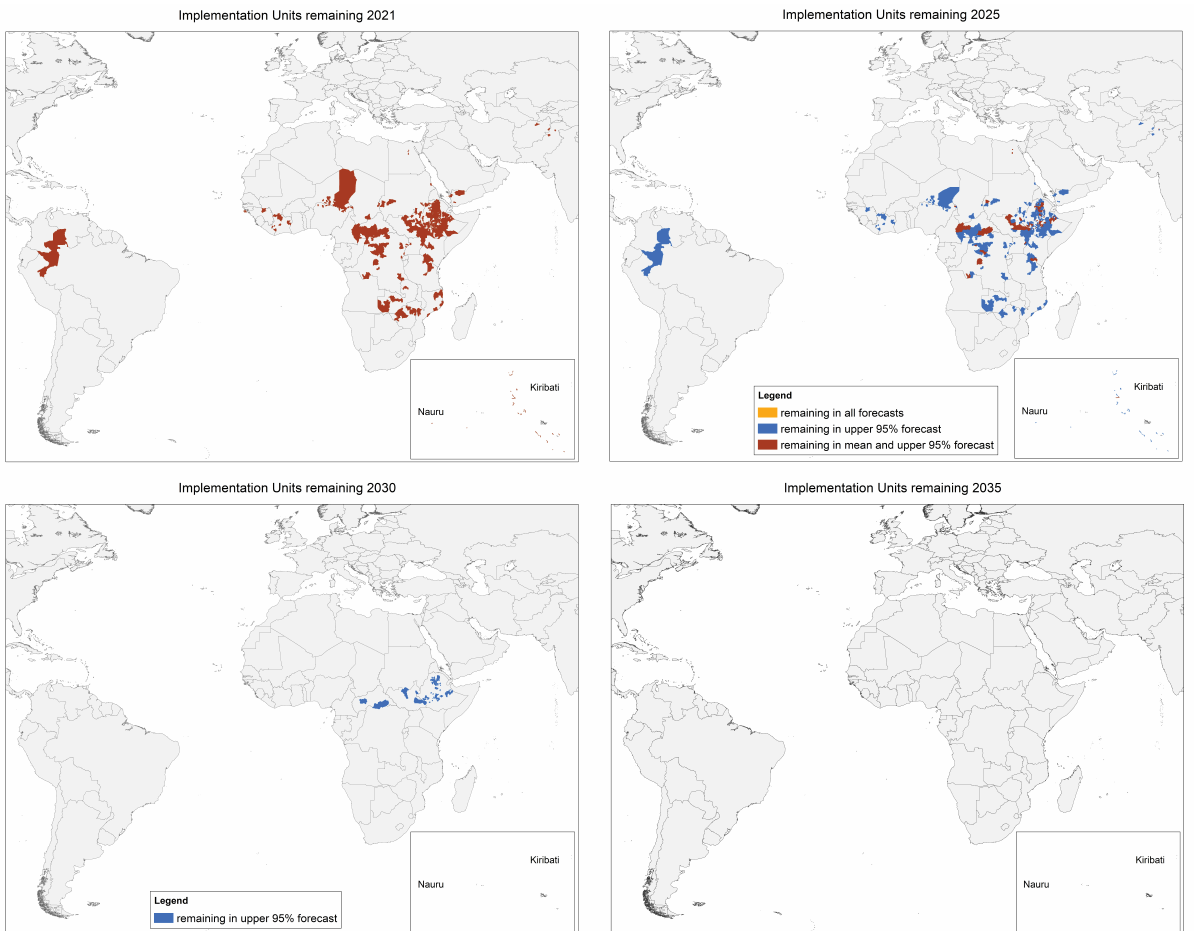
Fig 4. Maps showing the Implementation Units (IUs) known to remain requiring Mass Drug Administration (MDA) in 2021 and the mean, upper 95% CI, and lower 95% CI IUs forecast to remain requiring MDA in 2025, 2030, and 2035. Basemap provided by the International Trachoma